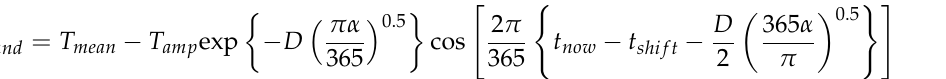
Figure 3. Ground temperature at a depth of 1.5 m and at the ground surface.